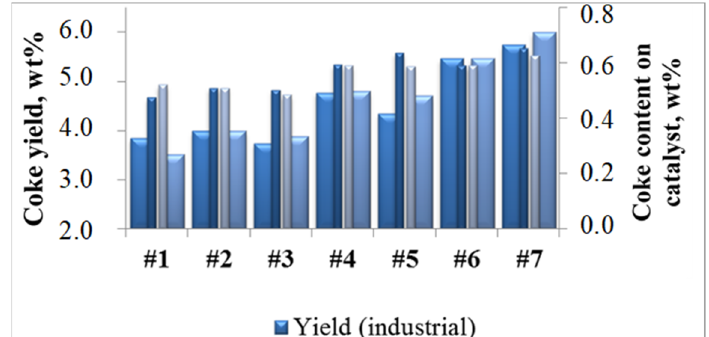
Figure 7. Comparison between model and experimental results by yields and content of coke on catalysts.